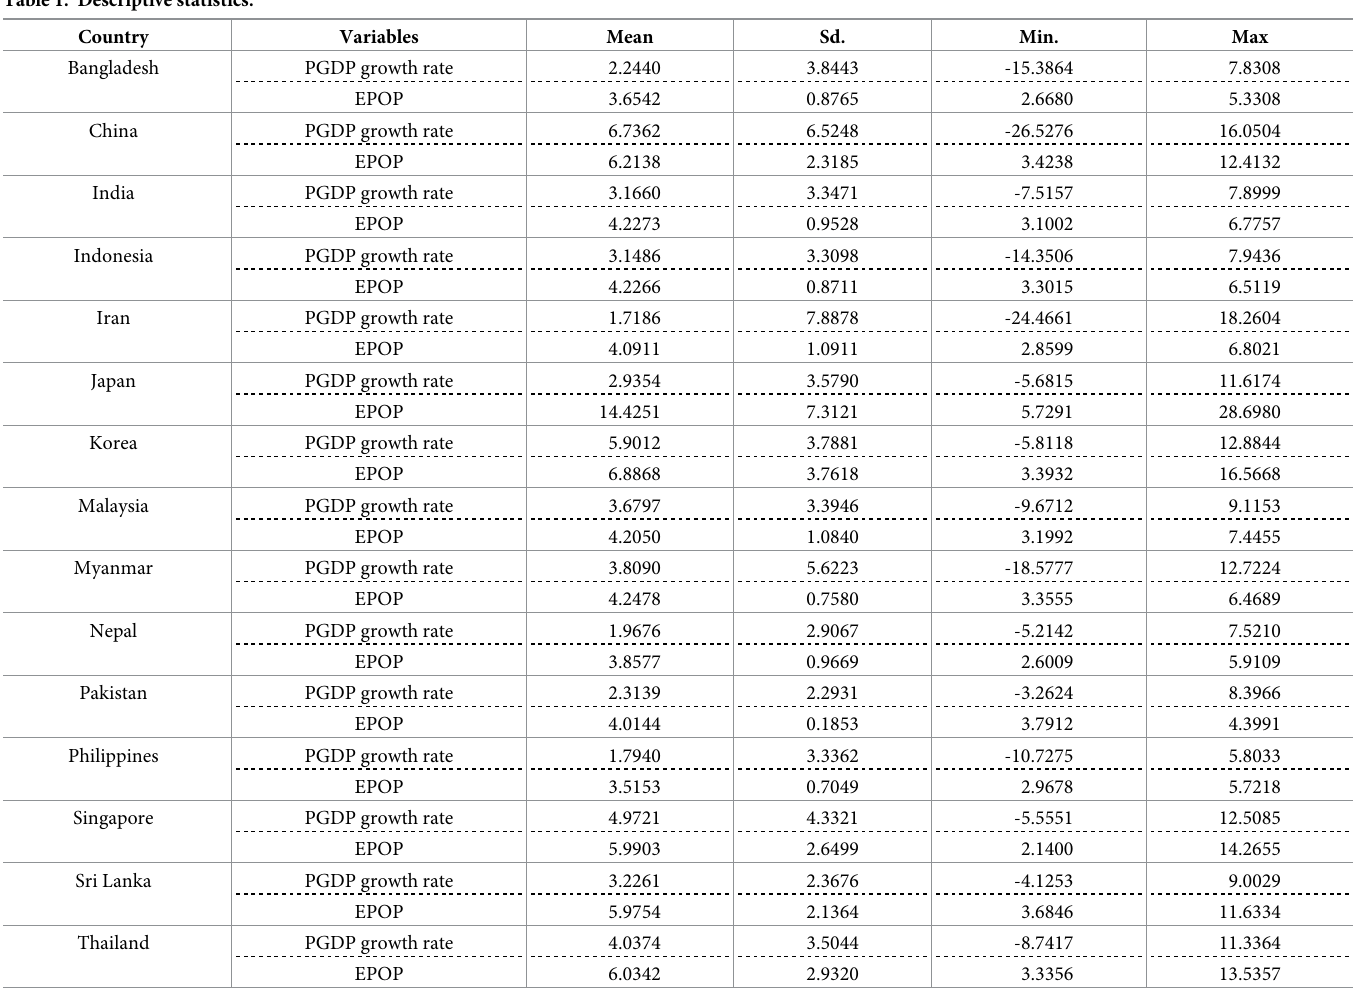
Table 1. Descriptive